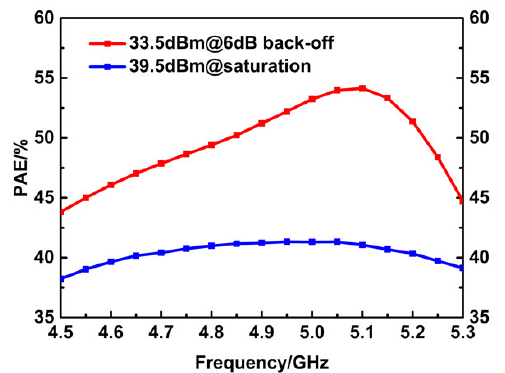
Figure 13. Simulated PAE from 4.5 GHz to 5.3 GHz.